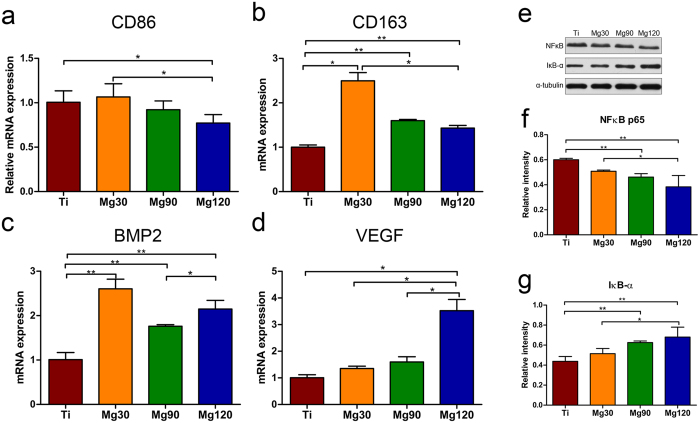
Relative mRNA expression levels of macrophage polarization markers and growth factors: (a) CD86, (b) CD163, (c) BMP2, (d) VEGF. (e) Western blot assay of the NF-κB signalling pathway-related proteins NF-κB and IκB-α, (f,g) Statistical results of relative protein bands intensity. (Statistically significant difference: *p < 0.05; **p < 0.01; triplicate). (BMP2: bone morphogenetic protein 2; VEGF: vascular endothelial growth factor; NF-κB: nuclear factor κB; IκB-α: nuclear factor of kappa light polypeptide gene enhancer in B-cells inhibitor alpha).